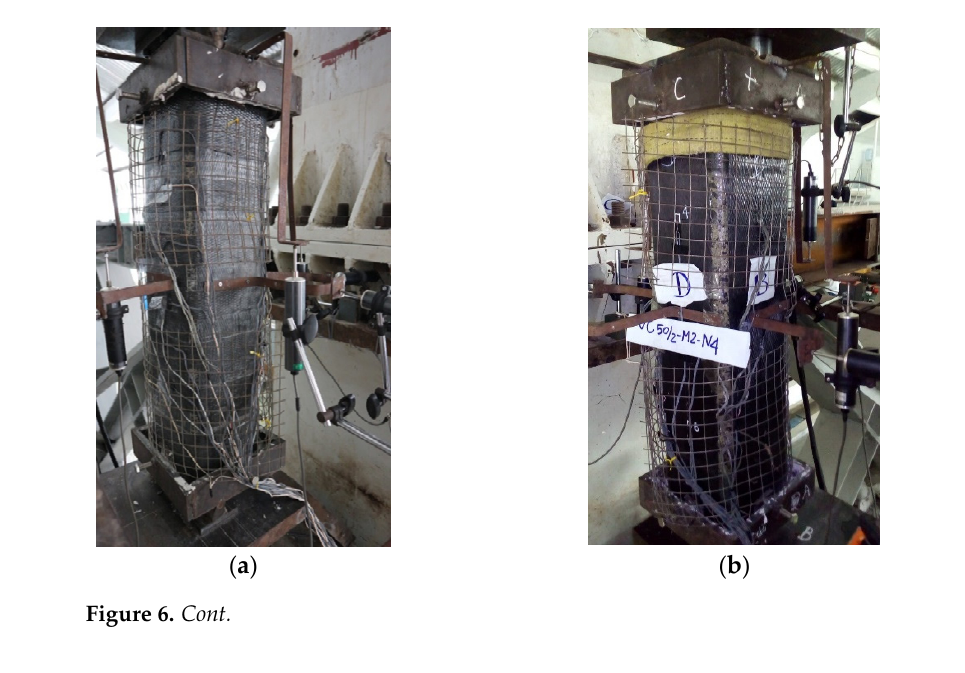
Figure 5. Eccentric loading mechanism; ( a ) Plan view; ( b ) Section A-A.